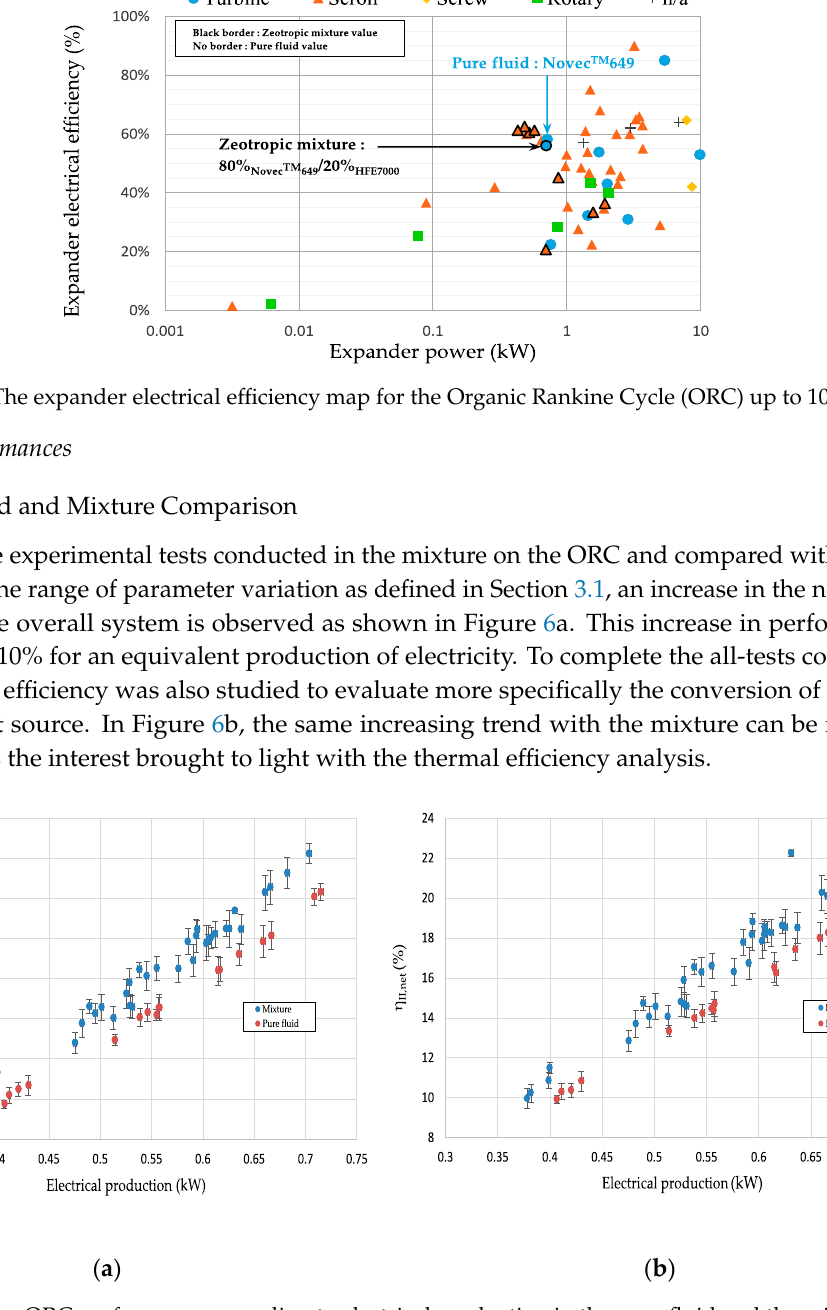
( a ) Thermal e ffi ciency; ( b ) Second law e ffi (a) Thermal efficiency; (b) Second law efficiency. 359